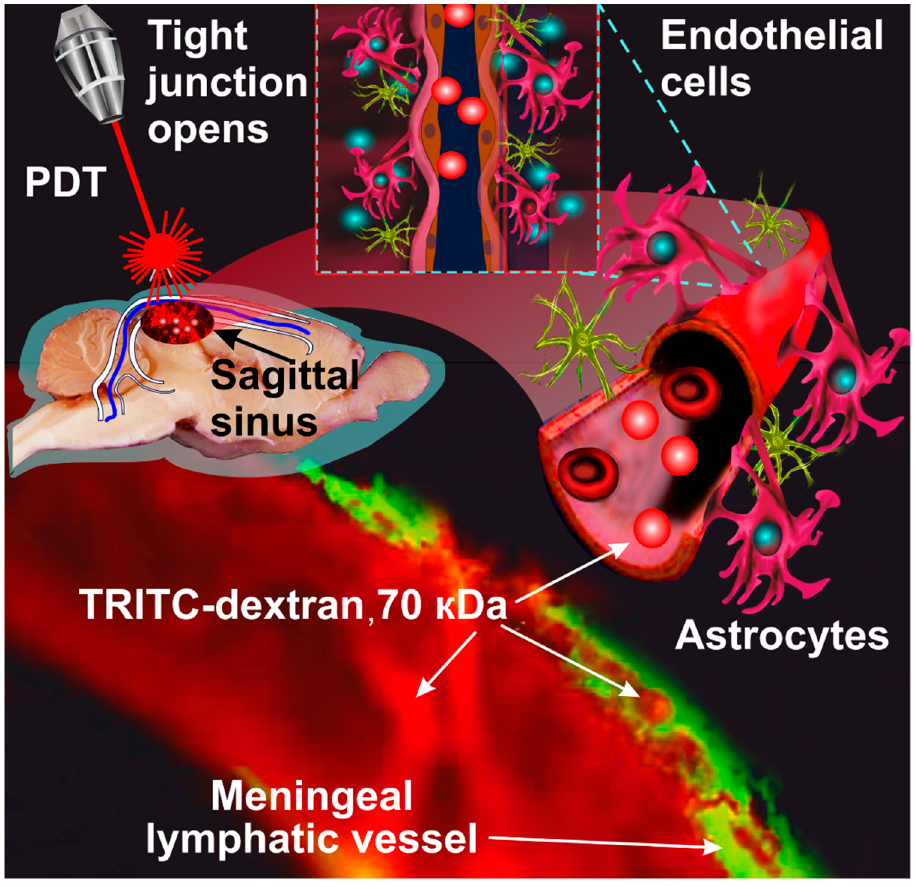
Figure 2. The lymphatic clearance of tracer from the brain after crossing the OBBB. The figure illustrates the fluorescent microscopy of the clearance of TRITC-dextran 70 kDa (red color) from the brain via the meningeal lymphatics (green color, labelled by the specific antibodies LYVE-1 conjugated with Alexa 488). The intravenously injected TRITC-dextran is immediately observed in the Sagittal sinus (the main cerebral vein), and 30 min later, it is also present in the meningeal lymphatics due to the PDT-OBBB-mediated activation of the lymphatic clearance of tracer from the brain [43].